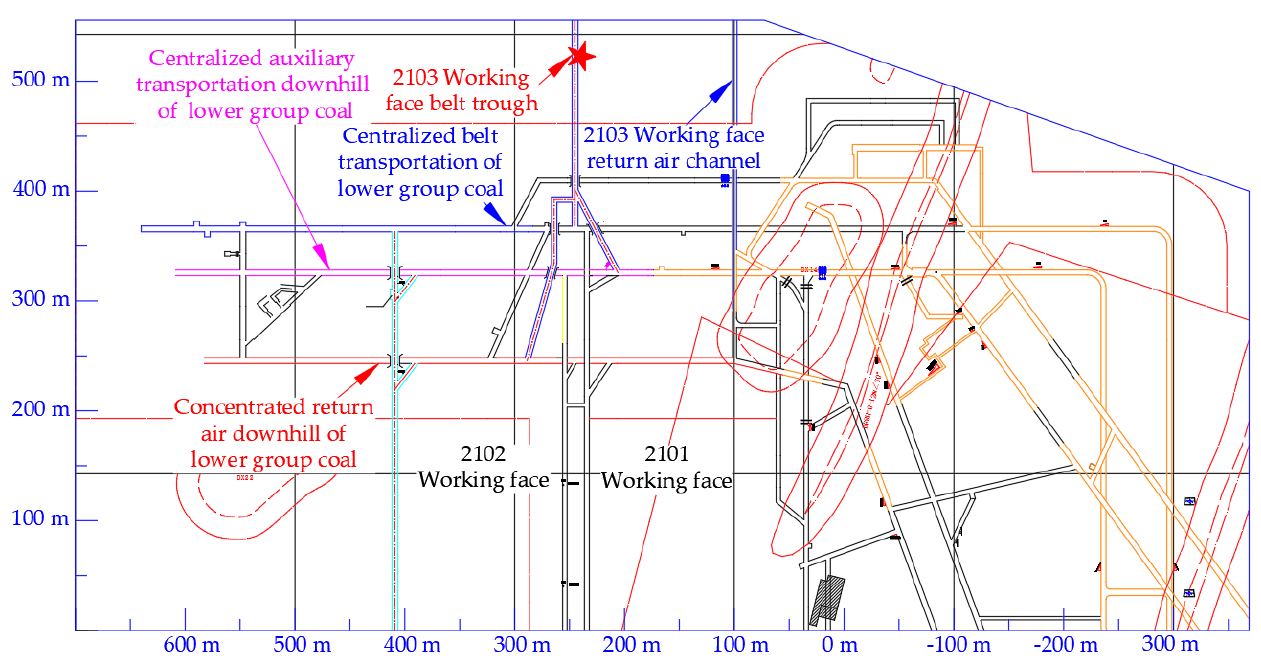
Figure 2. Plan of mining engineering.